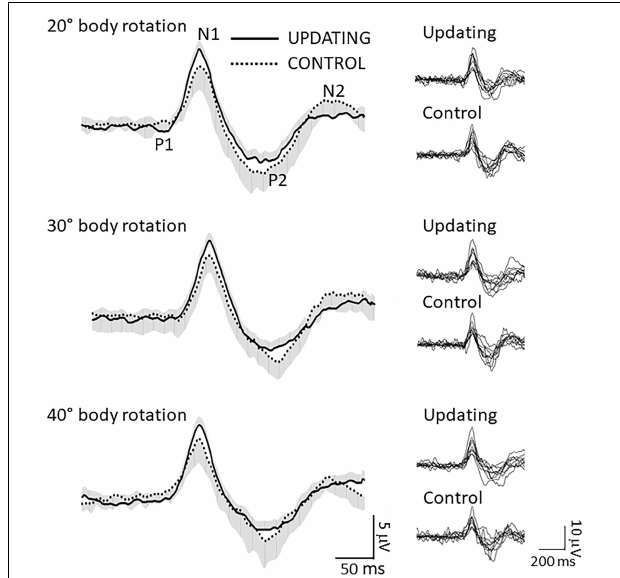
FIGURE 3 | Data related to the rotation evoked potentials (RotEP). (Left column) Grand average RotEP traces at electrode Cz (i.e., vertex) in the Updating and Control conditions for the 20 ◦ , 30 ◦ , and 40 ◦ body rotations. The shaded areas represent the standard deviation of the means (positive and negative, for the Updating and Control conditions, respectively). The averages were obtained after synchronizing the traces with respect to N 1 . Overall mean peak latencies: P 1 : 47 ± 12 ms; N 1 : 136 ± 12 ms; P 2 : 303 ± 35; N 2 : 470 ± 55 ms. (Right column) Individual RotEP of all participants in the Updating and Control conditions, for the 20 ◦ , 30 ◦ , and 40 ◦ body